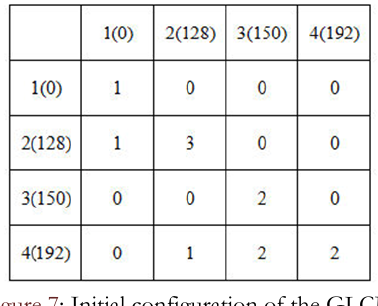
Figure 7: Initial configuration of the GLCM Figure 8: Final configuration for the